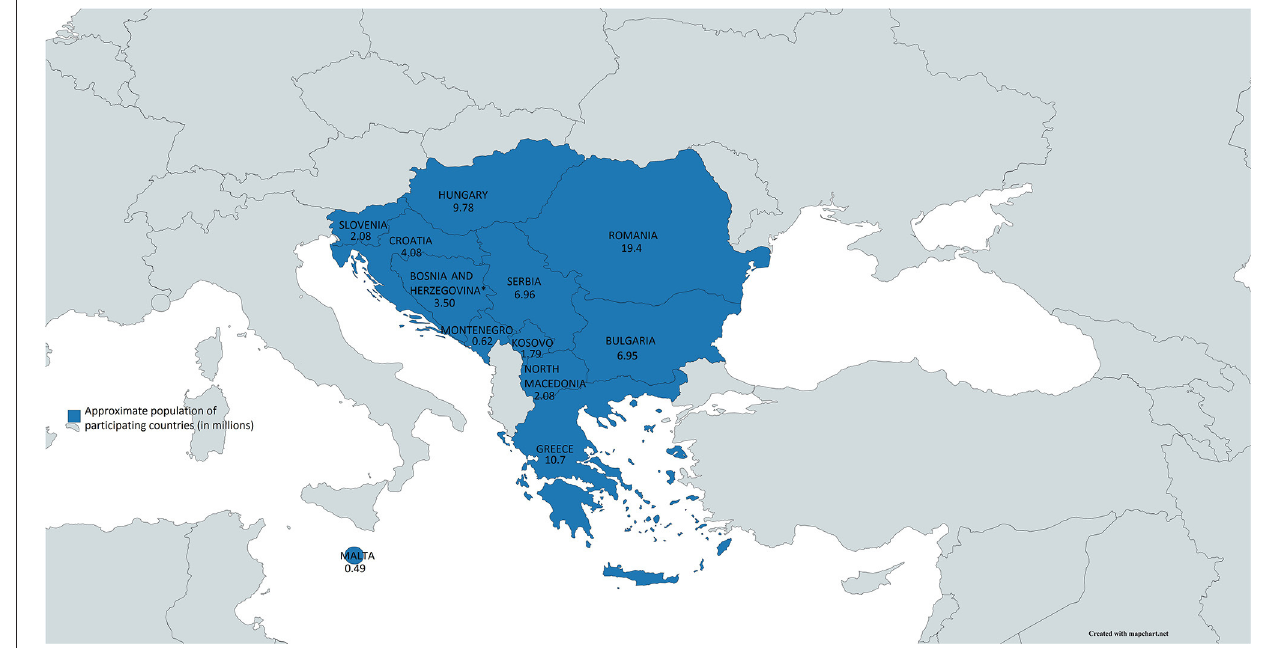
FIGURE 1 | The map of southeastern Europe with countries represented in the survey (in blue) and their populations.